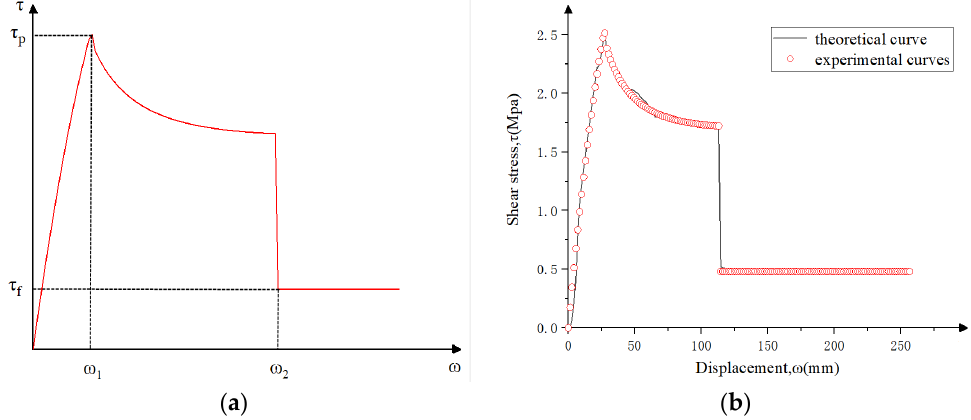
Figure 5. Shear stress–displacement curve of the proposed model. ( a ) Bond–slip models of the proposed model. ( b ) Fitting curve, as well as experimental and theoretical curves.